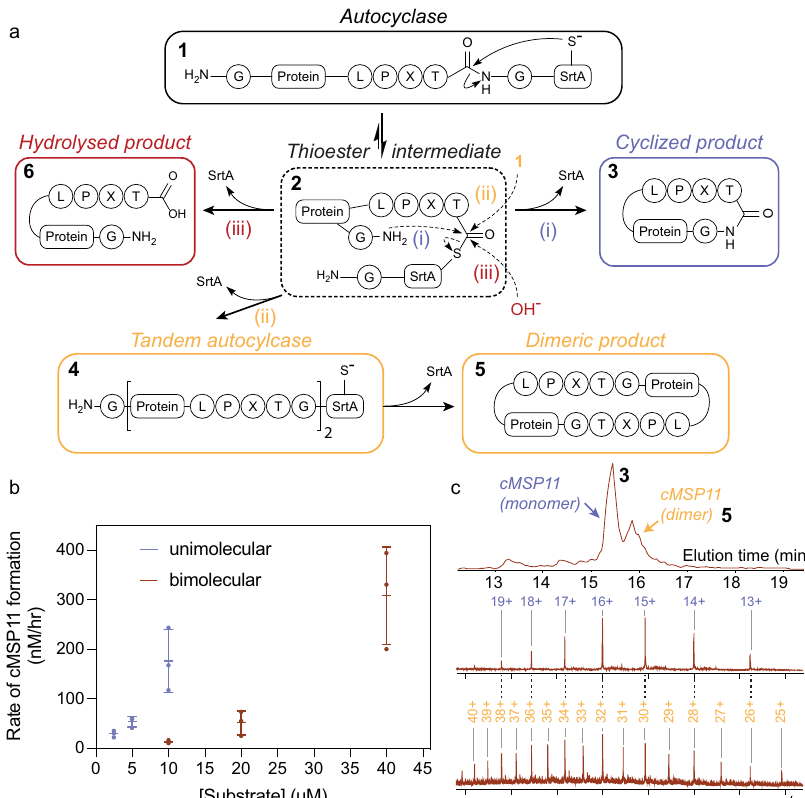
Fig. 2 The mechanism of autocyclisation. a A scheme summarising the main reaction pathways of autocyclases. After the generation of a thioester intermediate (2) from a spontaneous intramolecular rearrangement, the reaction can proceed via the following paths: (i) The unimolecular reaction — intramolecular nucleophilic attack by the N-terminal glycine amino group. This pathway results in the cyclised product (3) and free SrtA. (ii) Bimolecular reaction — intermolecular nucleophilic attack. This reaction results in a free SrtA and a protein-protein-SrtA adduct (4 — tandem autocyclase). This adduct can self-cyclise to form a cyclic dimer (5). (iii) Hydrolysis — the thioester is resolved by a hydroxide ion and, irreversibly, produces a linear hydrolyzed product (5). b The reaction rates of aMSP11-L 12 cyclisation are compared to the equivalent reaction using the traditional (bimolecular) enzymatic cyclisation method (using MSP11 and WT SrtA in both cases). Rates were determined by monitoring the build-up of cMSP11 using LC/MS. The rates demonstrate that the autocyclase reaction at lower starting concentrations approximates fi rst order reaction kinetics, while the bimolecular reaction approximates second order reaction kinetics. Error bars indicate standard deviations of the mean from three independent replicated experiments (individual data points shown as dots). c The MS spectrum (extracted ion chromatogram) of an aMSP11-L 12 cyclisation reaction at a high starting autocyclase concentration (200 μ M) shows the formation of cyclised monomeric and dimeric products. Identity of the two species were con fi rmed by the observed m/z ion